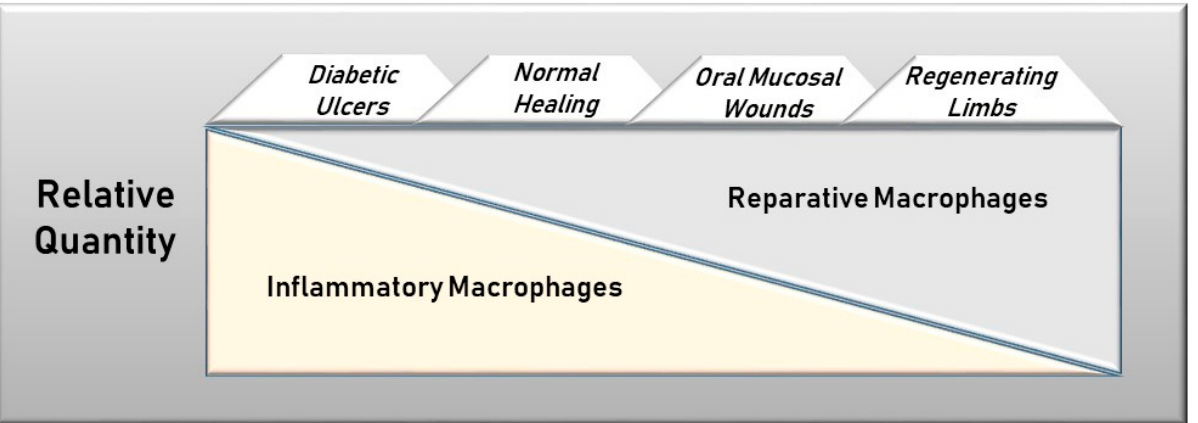
Figure 2. Relative levels of inflammatory versus reparative macrophages in differentially healing wounds. The healing outcome may depend upon the proportion of inflammatory versus reparative macrophages in the wound. In non-healing diabetic ulcers, inflammatory macrophages are predominant, while only reparative macrophages are found in regenerative limbs of salamanders. Oral mucosal wounds have both types of macrophages, but the reparative phenotype domi- nates.